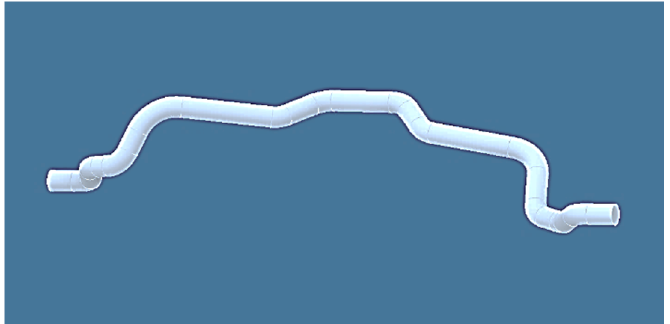
Figure 1. Example of 3D geometrically complicated non-bearing core frame used to reinforce chassis of passenger car.